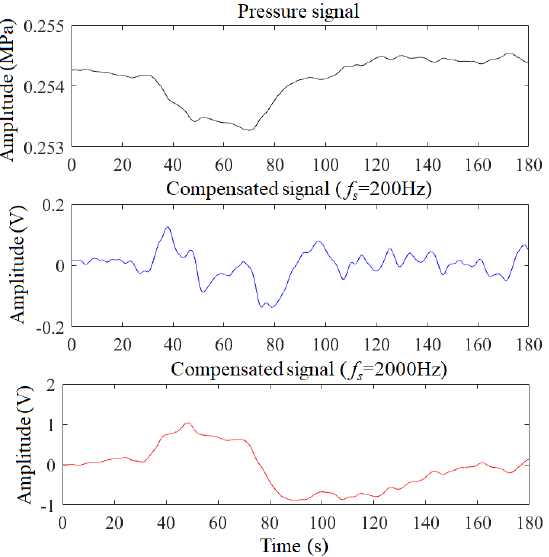
Figure 7. Compensated signals with different discretization frequency f s